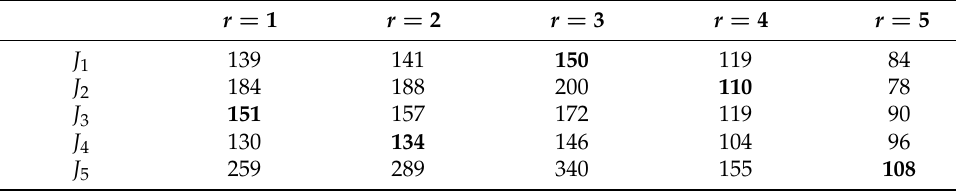
Table 4. Values τ jr for m = 2 and w = 3 (bold numbers are the optimal solution).